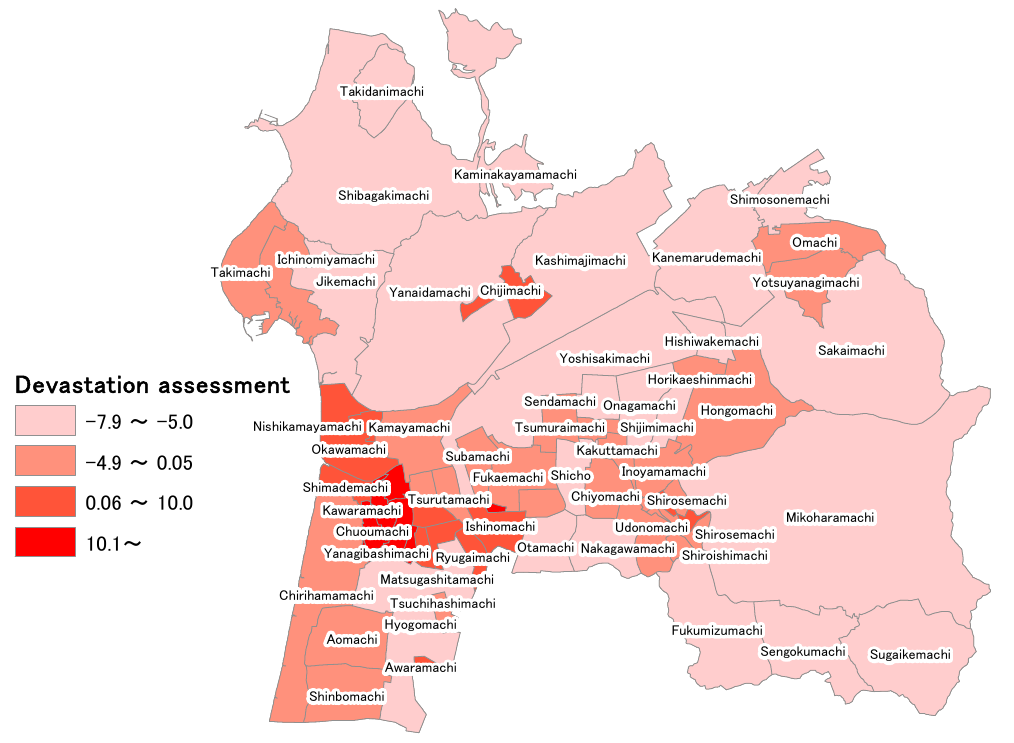
Figure 7. Visualization of the devastation assessment in each neighborhood. Int. J. Environ. Res. Public Health 2018 , 15 , x